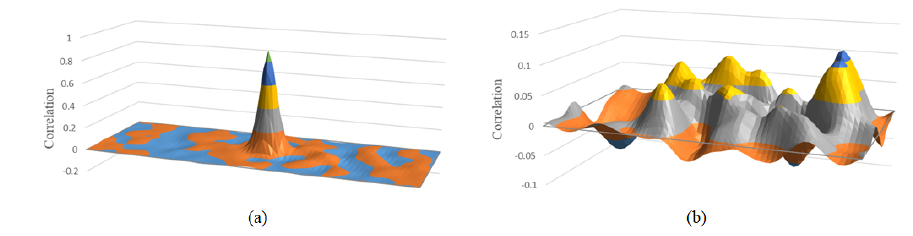
Figure 2. ( a ) Common form of correlation distribution from successful tracking sequences. ( b ) An example of correlation distribution from tracking sequences with challenging